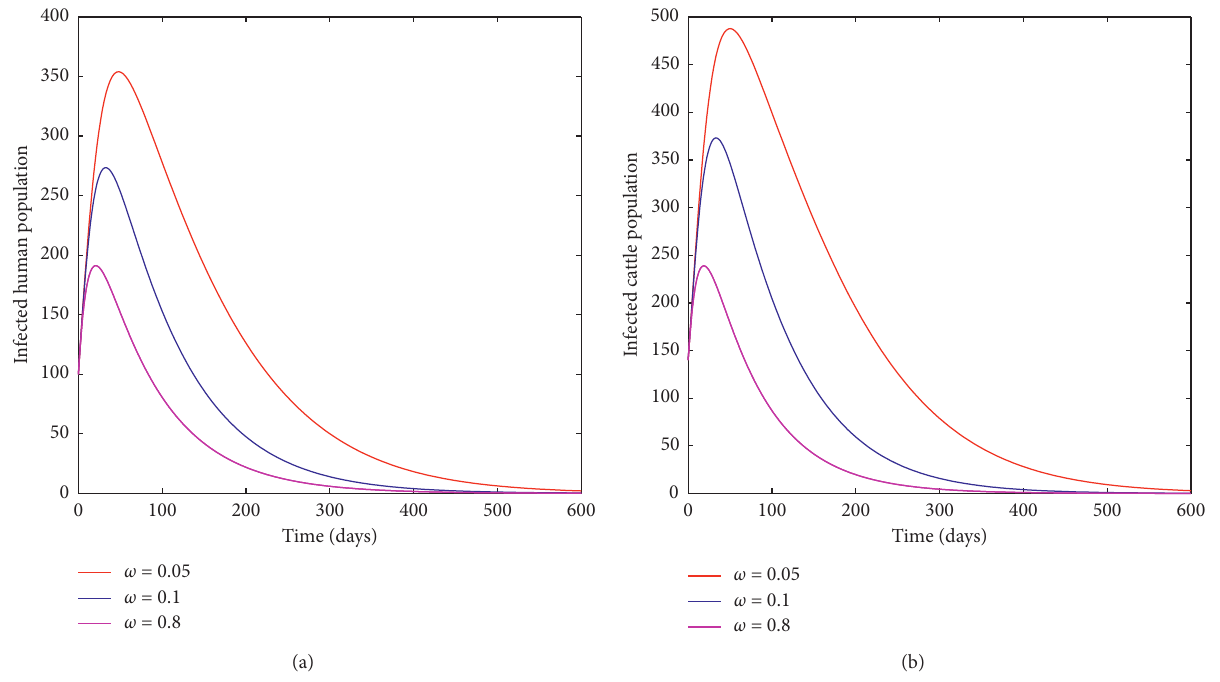
Figure 6: Variation in trapping rate on infected human and cattle